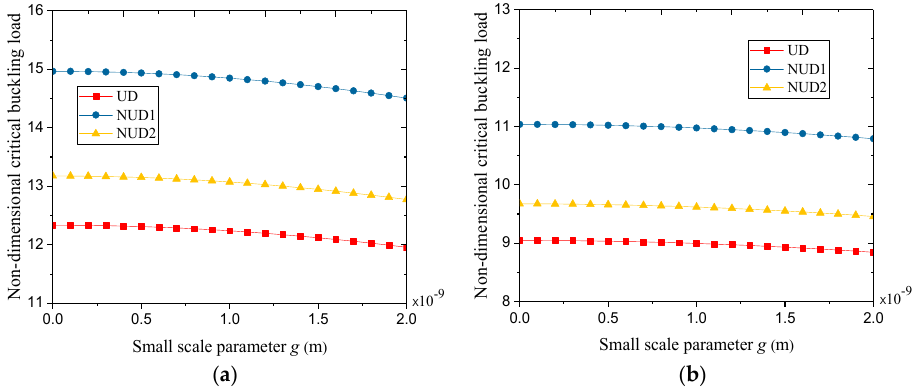
Figure 5. Variation of non-dimensional critical buckling load with a small-scale parameter g : ( a ) square nanoplate ( l a = l b = 50 nm), ( b ) rectangular nanoplate ( l a = 50 nm, l b = 75 nm).